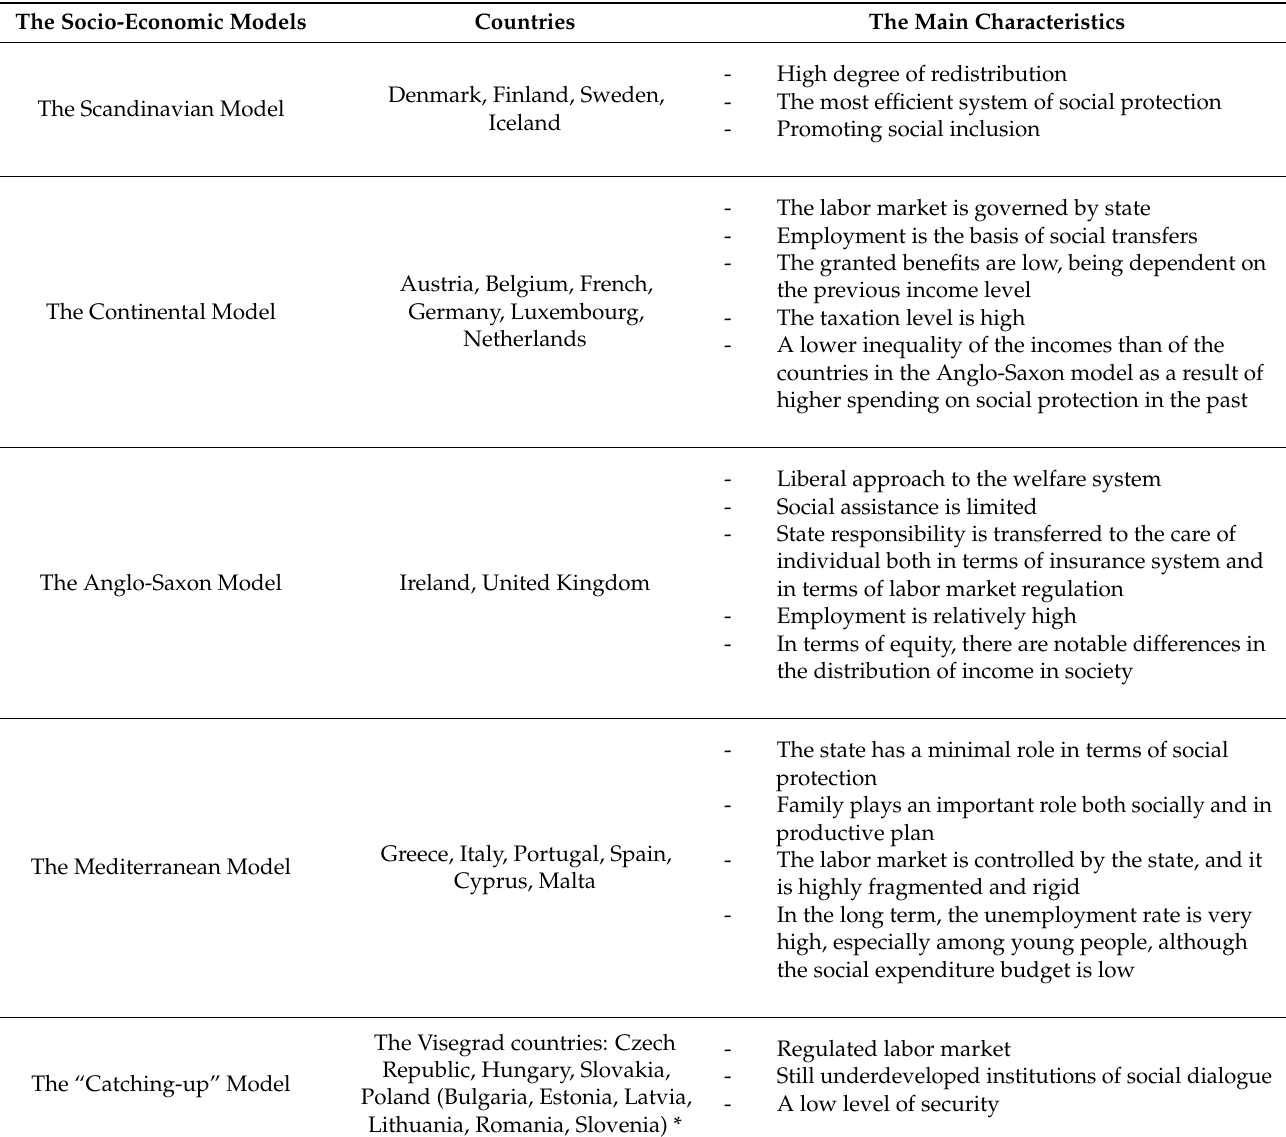
Table 1. Synoptic of the five socio-economic models’ characteristics.